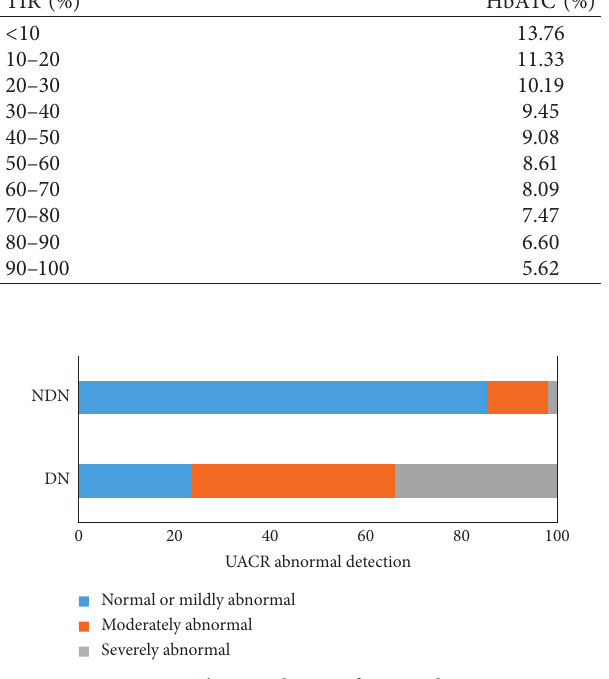
Figure 2: The correlation of DN with ACR.